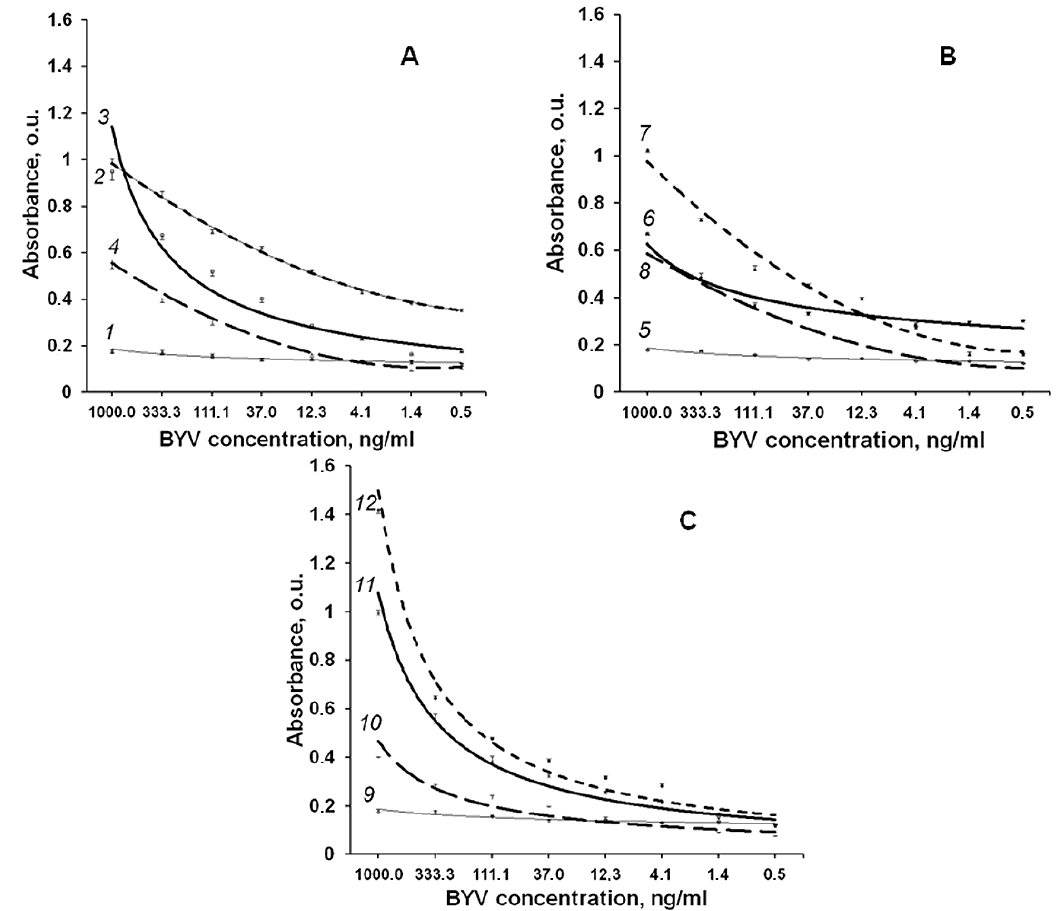
Figure 7. Sensitivity of the obtained antisera. ( A ) antiserum to ep1 ; ( B ) antiserum to ep2 ; ( C ) antiserum obtained to mix of the epitopes ep1 and ep2 . Curves’ numbers show antiserum-antigen pairs analysed: 1, 5, 9—pre-immune sera and native BYV; 2—antiserum to ep1 and ep1 ; 3—antiserum to ep1 and native BYV; 4—antiserum to ep1 and healthy plant control; 6—antiserum to ep2 and native BYV; 7 antiserum to ep2 and ep2 ; 8—antiserum to ep2 and healthy plant control; 10—antiserum obtained to the mix of epitopes ep1 , ep2 and healthy plant control; 11—antiserum obtained to the mix of epitopes ep1 , ep2 and native BYV; 12—antiserum obtained to the mix of epitopes ep1 , ep2 and mix of these